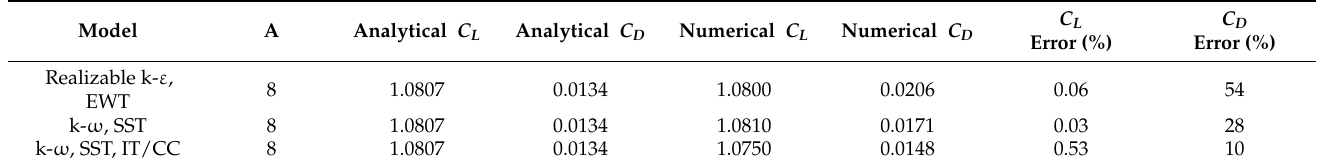
Table 3. Turbulence model effects on C L and C D .